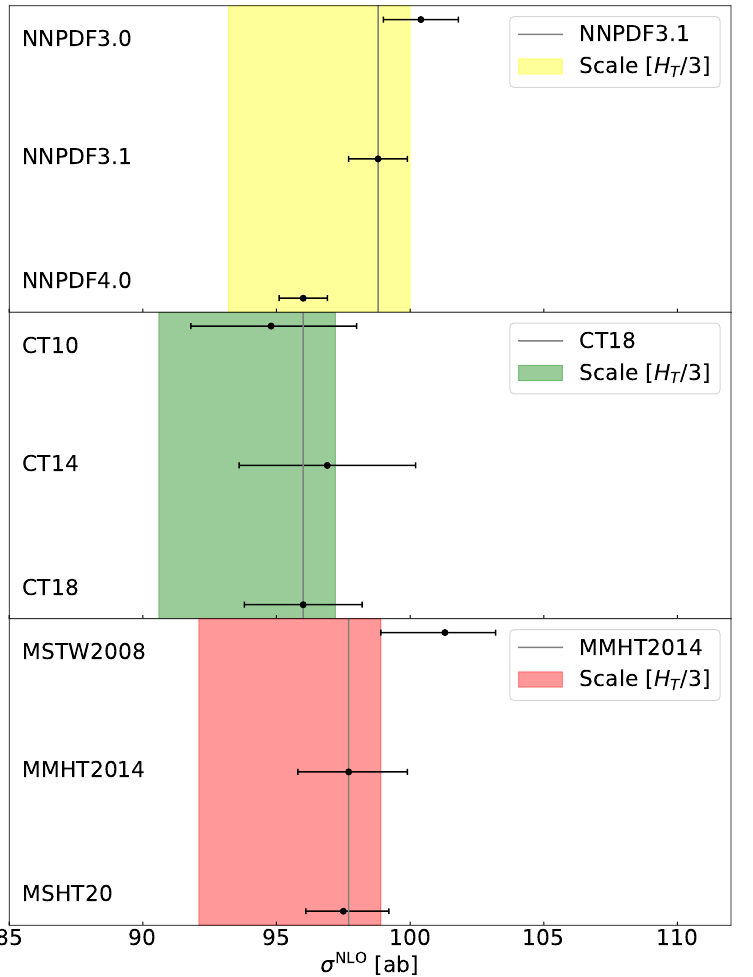
Figure 5 . NLO integrated fiducial cross sections for pp → e + ν e µ − ¯ ν µ b ¯ b τ + τ − + X at the LHC with √ s = 13 TeV. Theoretical results are provided for µ R = µ F = µ 0 = H T / 3 as well as for various PDF sets. Scale uncertainties are reported for the NNPDF3.1 PDF set (yellow band), for CT18 (green band) as well as for MMHT2014 (red